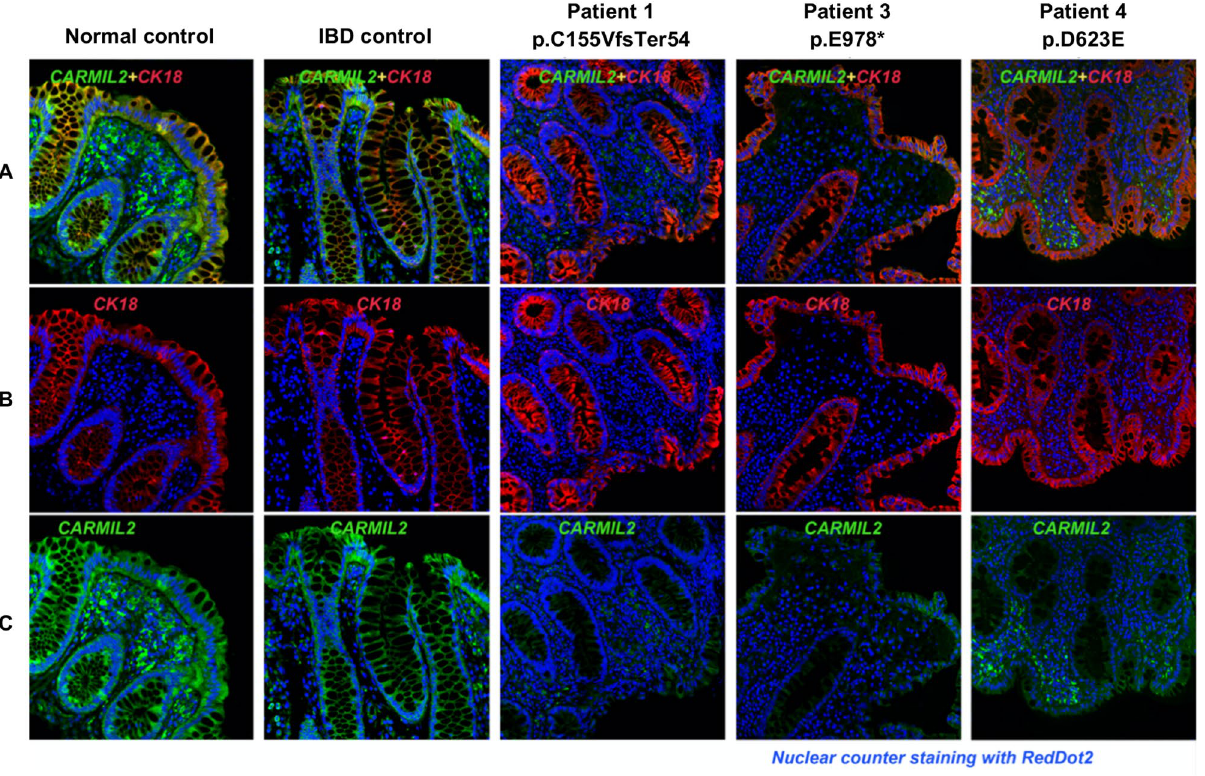
Figure 3. Dual immunofluorescence staining for CARMIL2 protein and CK18 on sigmoid FFPE sections of healthy control, IBD control, and three biallelic CARMIL2 variant carriers diagnosed with IBD. DAPI counterstaining was used to visualize nuclei. ( A ) Composite image, where green staining indicates CARMIL2, red represents cytokeratin 18 (CK18), a marker for single layer epithelial cells, and blue marks nuclear DAPI stain. In Patient 1 and Patient 3, carriers of the two protein-truncating variants (respectively p.C155VfsTer54 and p.E978*), CARMIL2 signal was almost absent in sigmoid sections. In Patient 4, carrier of missense